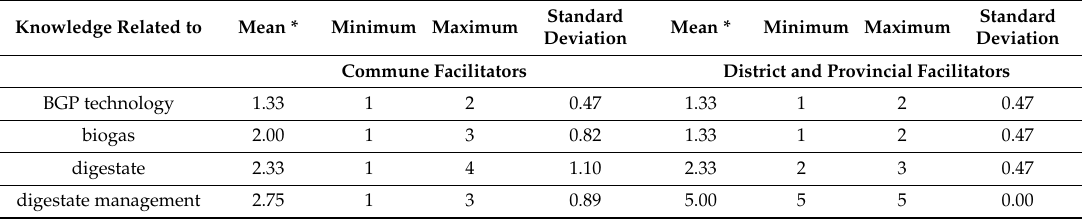
Table 3. Self-assessment of specific issues connected with biogas technology—commune facilitators ( n = 6) and district and provincial facilitators ( n = 3).